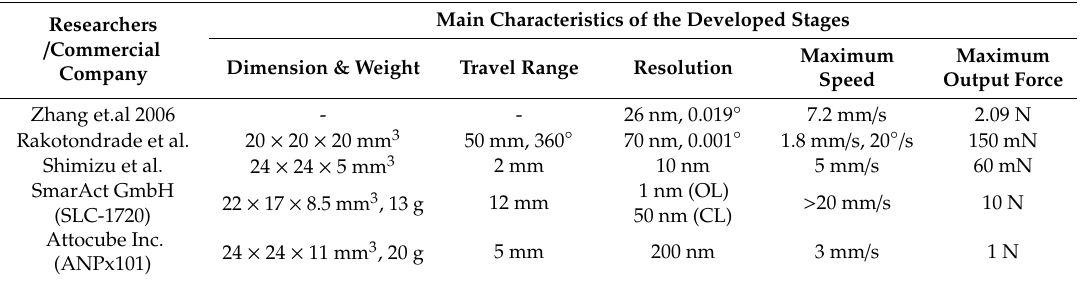
Table 1. Main characteristics of the developed stages of previous studies.